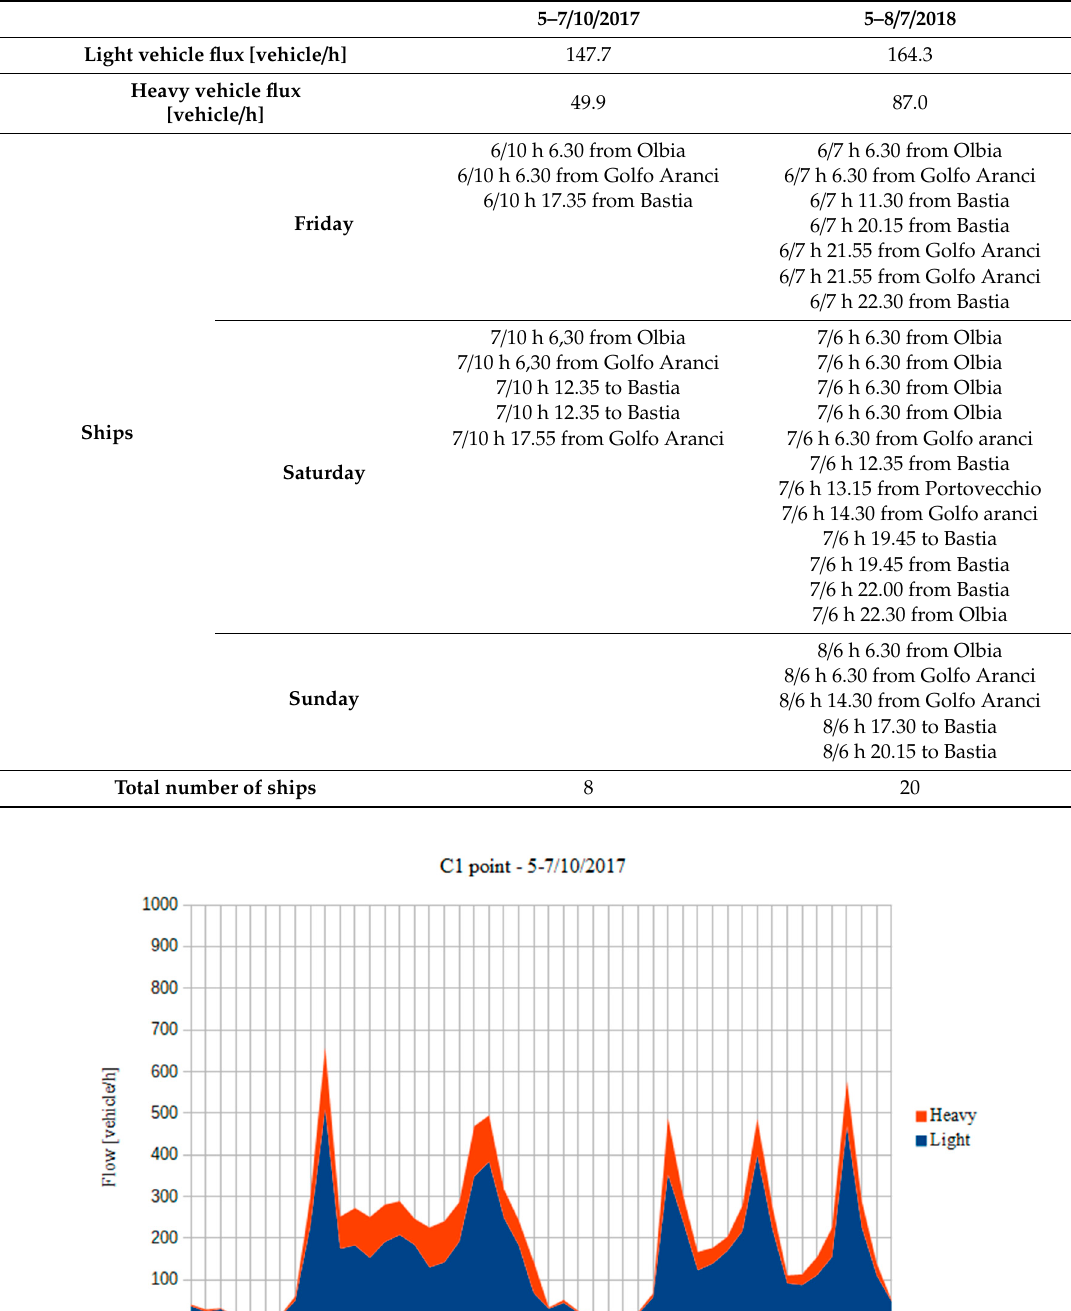
Table 6. The number of ships and vehicle flux in October and in July.